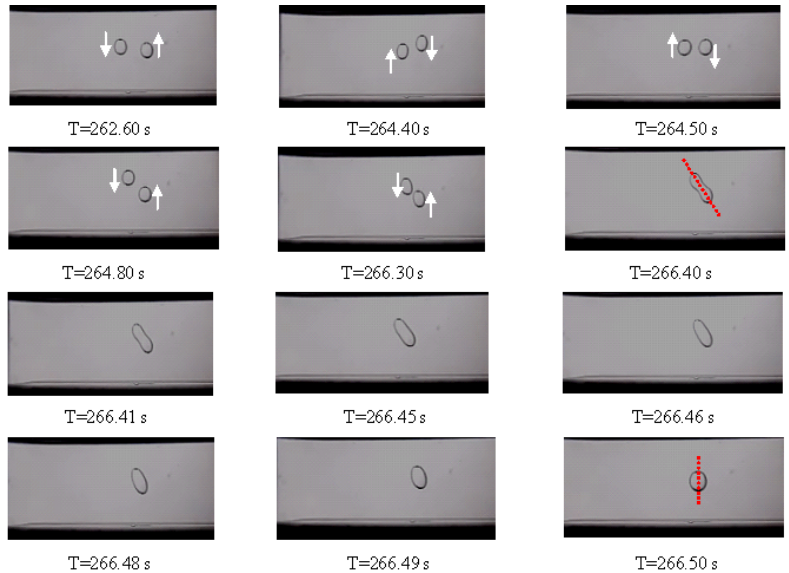
Fig. 4. Interaction leading merging between two water drops at Ca